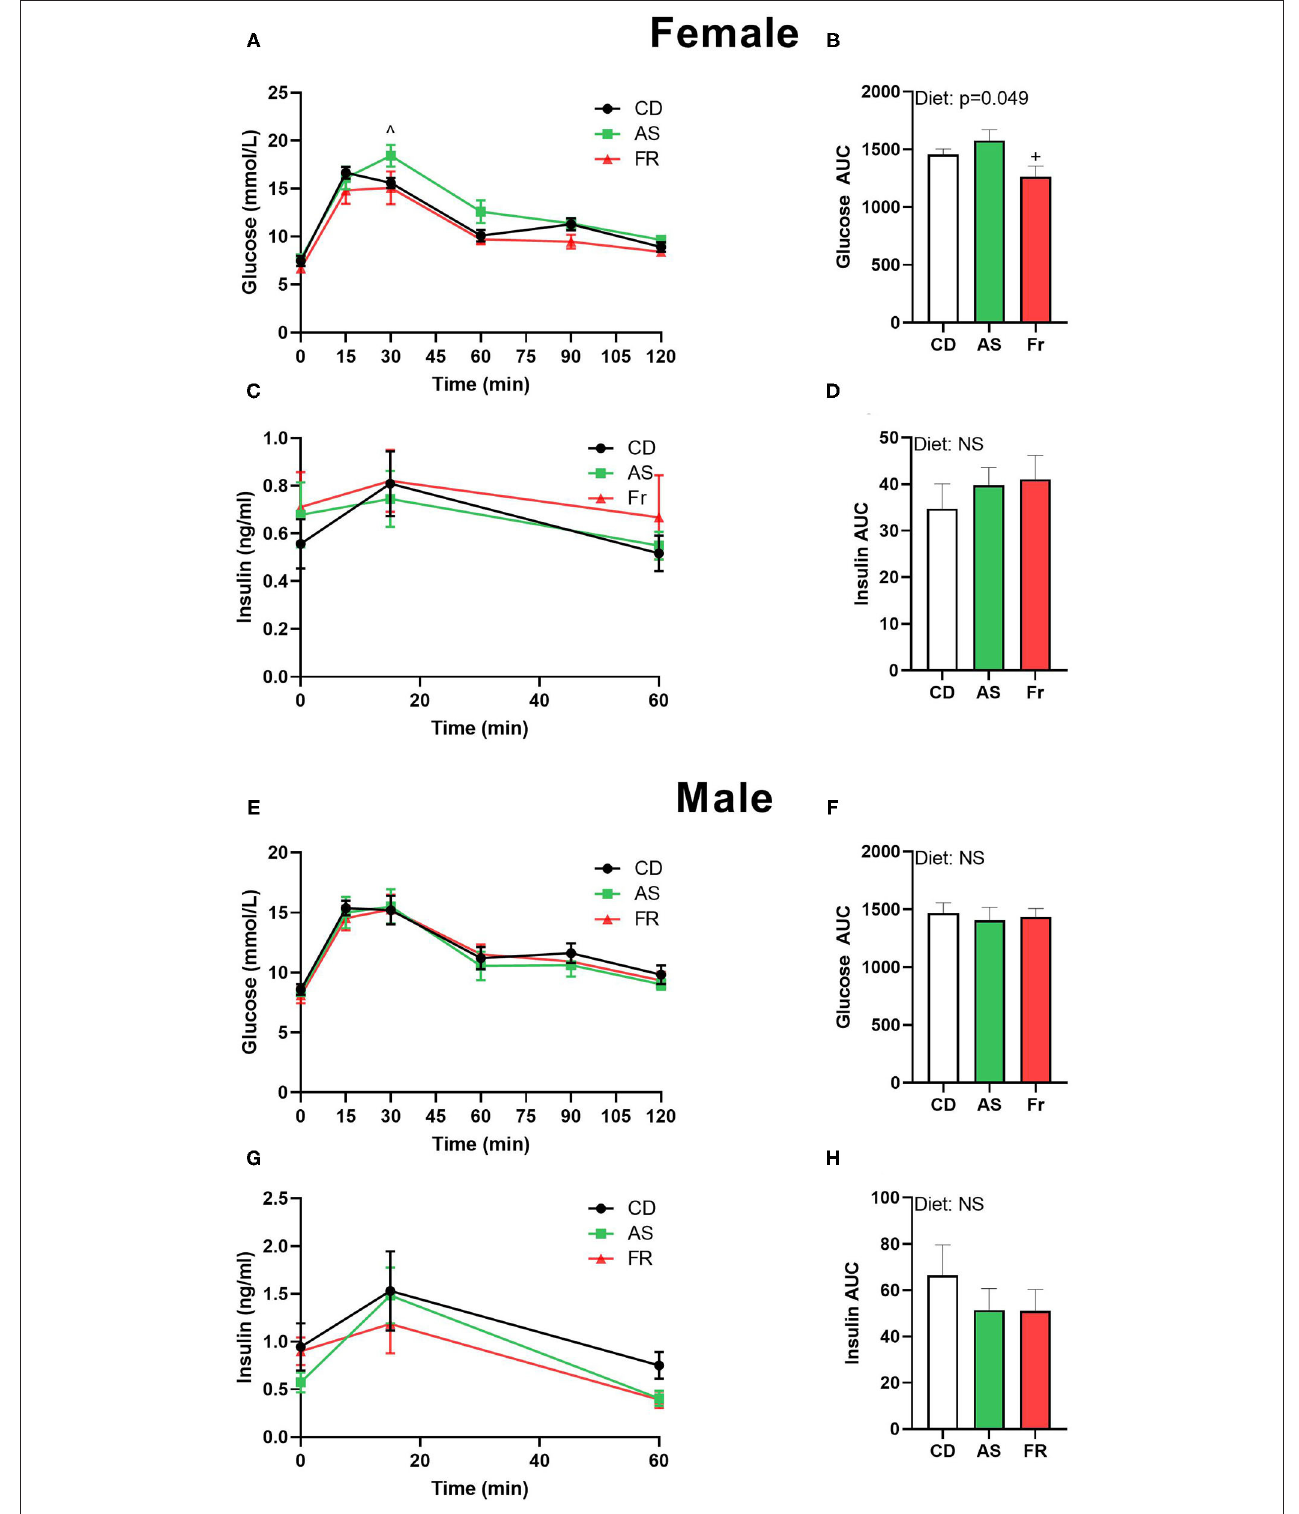
FIGURE 1 | The impact of maternal Ace-K (AS) and fructose (Fr) intake compared to Controls (CD) on glucose homeostasis at 12 weeks of age in female and male C57BL/6 offspring. OGTT (2 g/kg) in female (A) and male (E) offspring. Area under the OGTT curves in female (B) and male (F) offspring. Plasma insulin secretion curve at 0, 15, and 60min post-OGTT in female (C) and male (G) offspring. Area under the curve in insulin in female (D) and male (H) offspring. OGTT data were analyzed using repeated measures ANOVA, AUC by ANOVA. Data are expressed as mean ± SEM. + P < 0.05w.r.t AS. ∧ P < 0.05w.r.t Fr; n = 8 per sex per group.